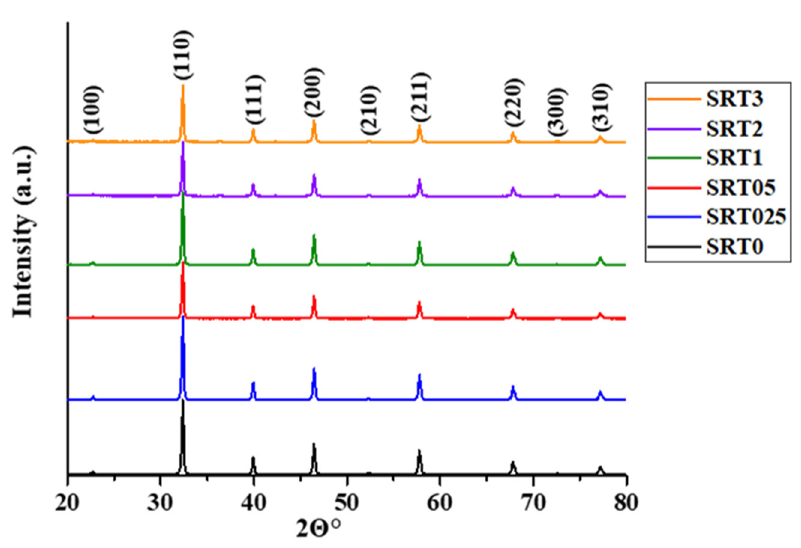
Figure 1. XRD patterns of SrTiO 3 and copper modified SrTiO 3 samples (SRTX).